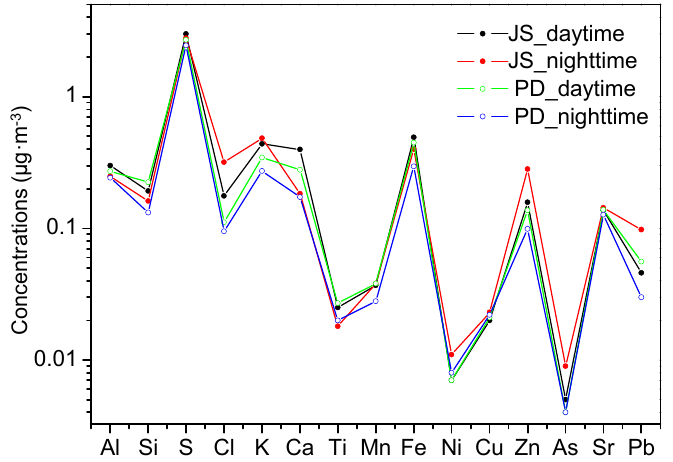
Figure 4. Concentrations of elements in PM 2.5 during daytime and nighttime at Pudong and